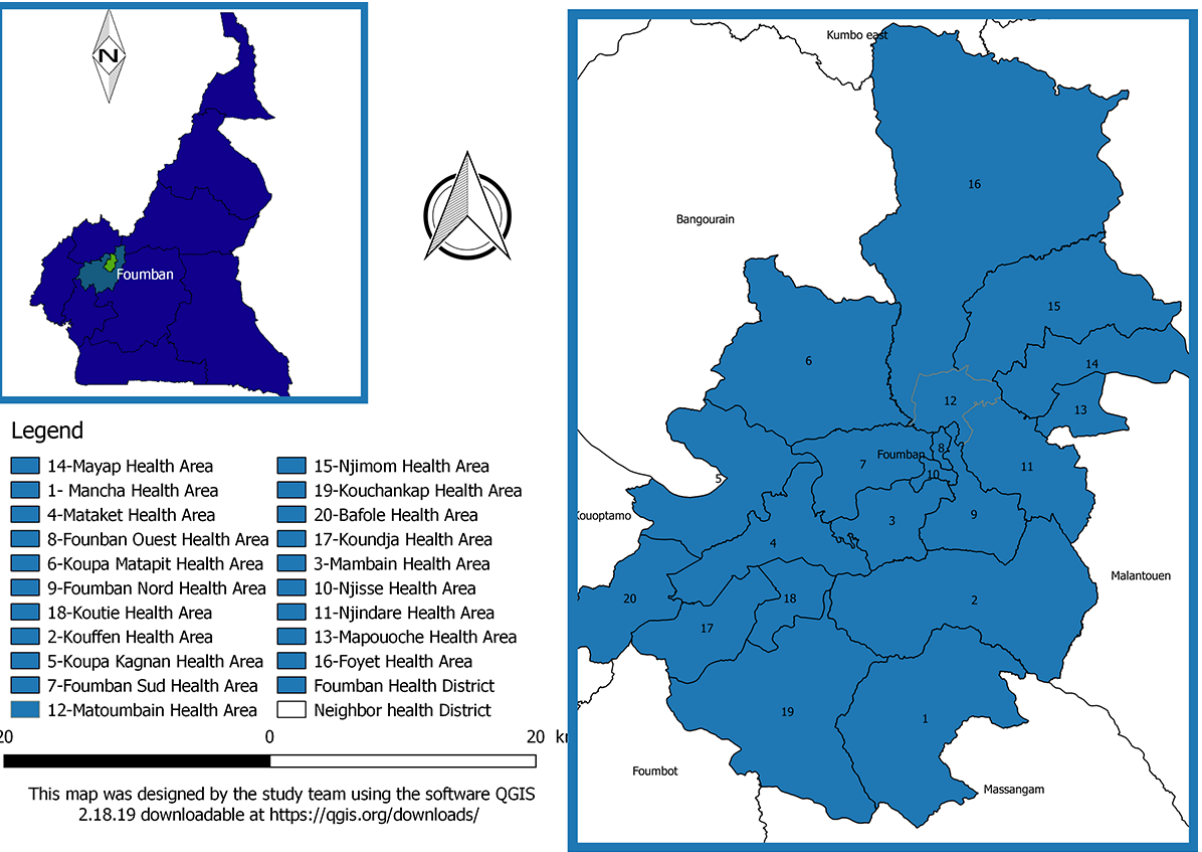
Figure 2. Map of the Foumban Health